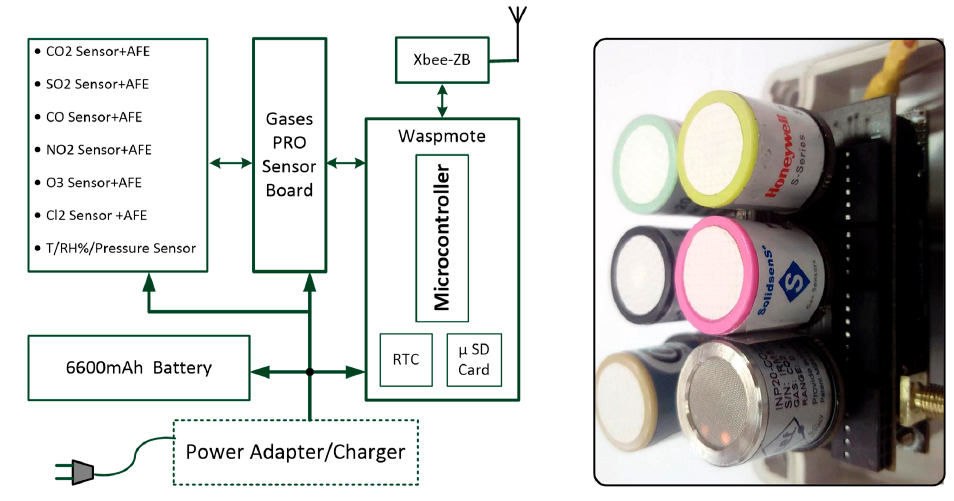
Figure 2. Gas sensors node for IAQM.